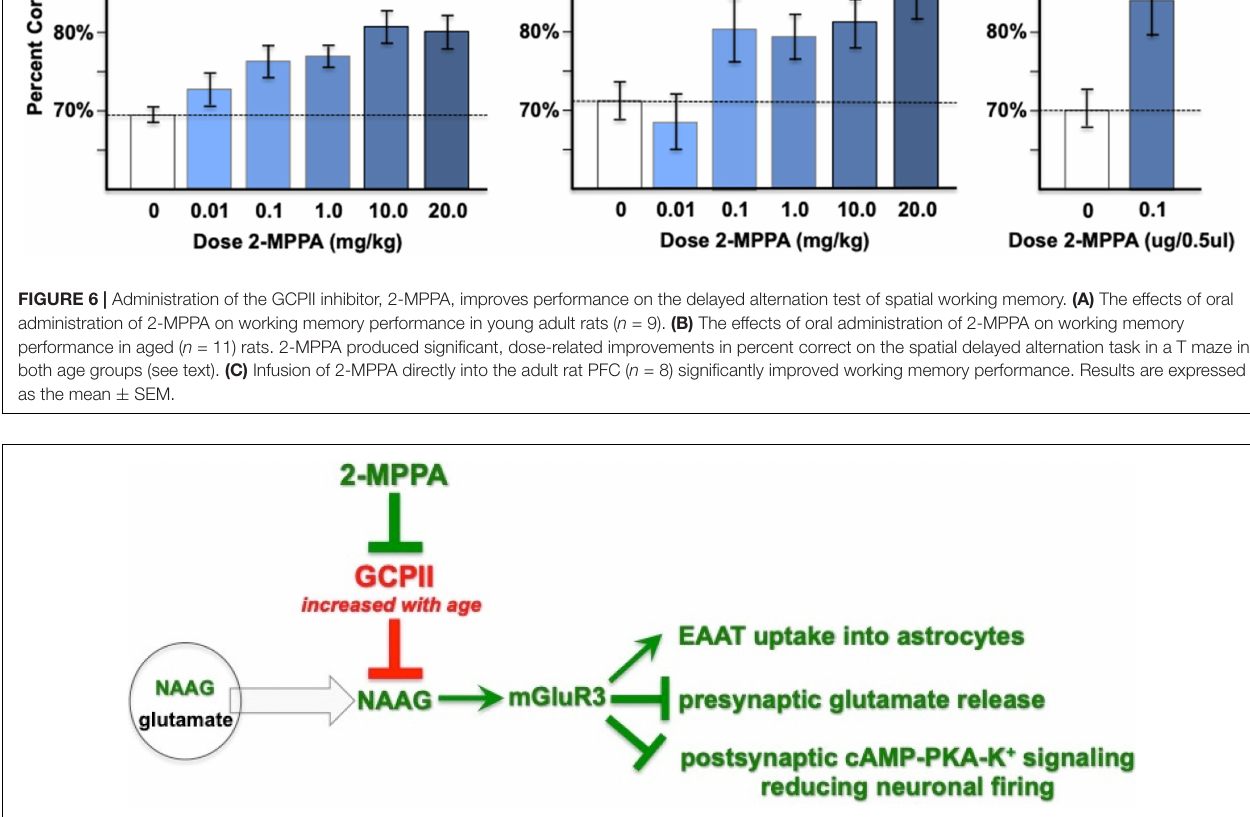
FIGURE 7 | Schematic diagram of 2-MPPA inhibition of GCPII-NAAG-mGluR3 signaling, and some of the mechanisms in mPFC that may influence working memory performance. NAAG is co-released with glutamate from presynaptic vesicles, but unlike glutamate, is selective for mGluR3. GCPII catabolizes NAAG, while 2-MPPA inhibits GCPII activity, increasing NAAG stimulation of mGluR3. Acute increases in NAAG-mGluR3 signaling with 2-MPPA administration may improve working memory performance via a number of mechanisms, including limiting the spread of glutamate actions via increased glutamate uptake into astroctyes via excitatory amino acid transporters (EEATs) and reduced glutamate release from axons, and/or strengthening of network connections via post-synaptic mGluR3 inhibition of cAMP-K + channel signaling on